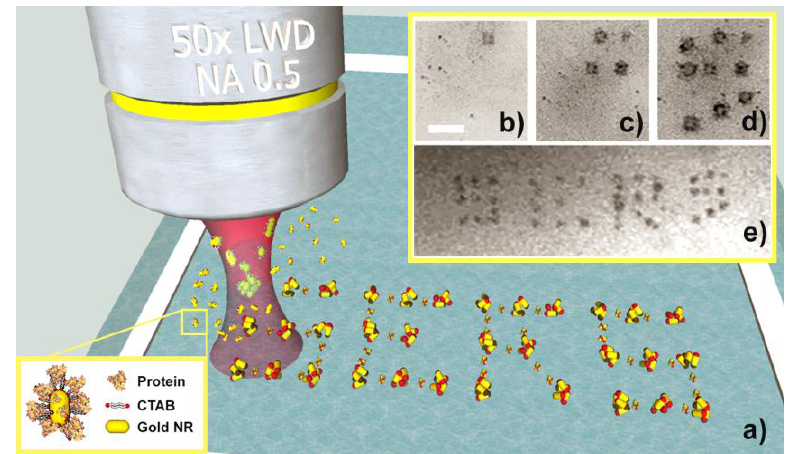
Figure 1. ( a ) Sketch of the LIQUISOR methodology in which a focused laser beam is used to optically aggregate BIO-NRC complexes (inset) dispersed in solution. ( b – d ) Optical pictures of BIO-NRC aggregates produced sequentially to print the word “SERS” ( e ) in liquid. Scale bar in ( e ) is 15 µm. Optical printing of each spot requires ca. 3 min.